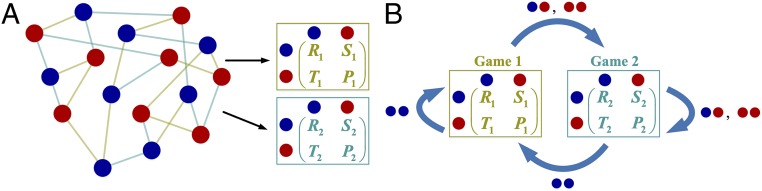
Game transitions on graphs. Each player occupies a node on the graph and has a strategic behavior, blue (“cooperate”) or red (“defect”), used in interactions with neighbors (A). In every time step, each player plays a game with every neighbor and accumulates its payoffs from all interactions. Games in different interactions can be different, highlighted by the color of edges and relevant payoff matrices. At the end of each time step, a random player is selected to be replaced, and all games update. Players’ behaviors and the game that they played in one time step determine the game to be played in the next time step (B). For example, if both players choose to take “red” behaviors in game 1 (i.e., mutual defection), they will play game 2 in the subsequent time step.